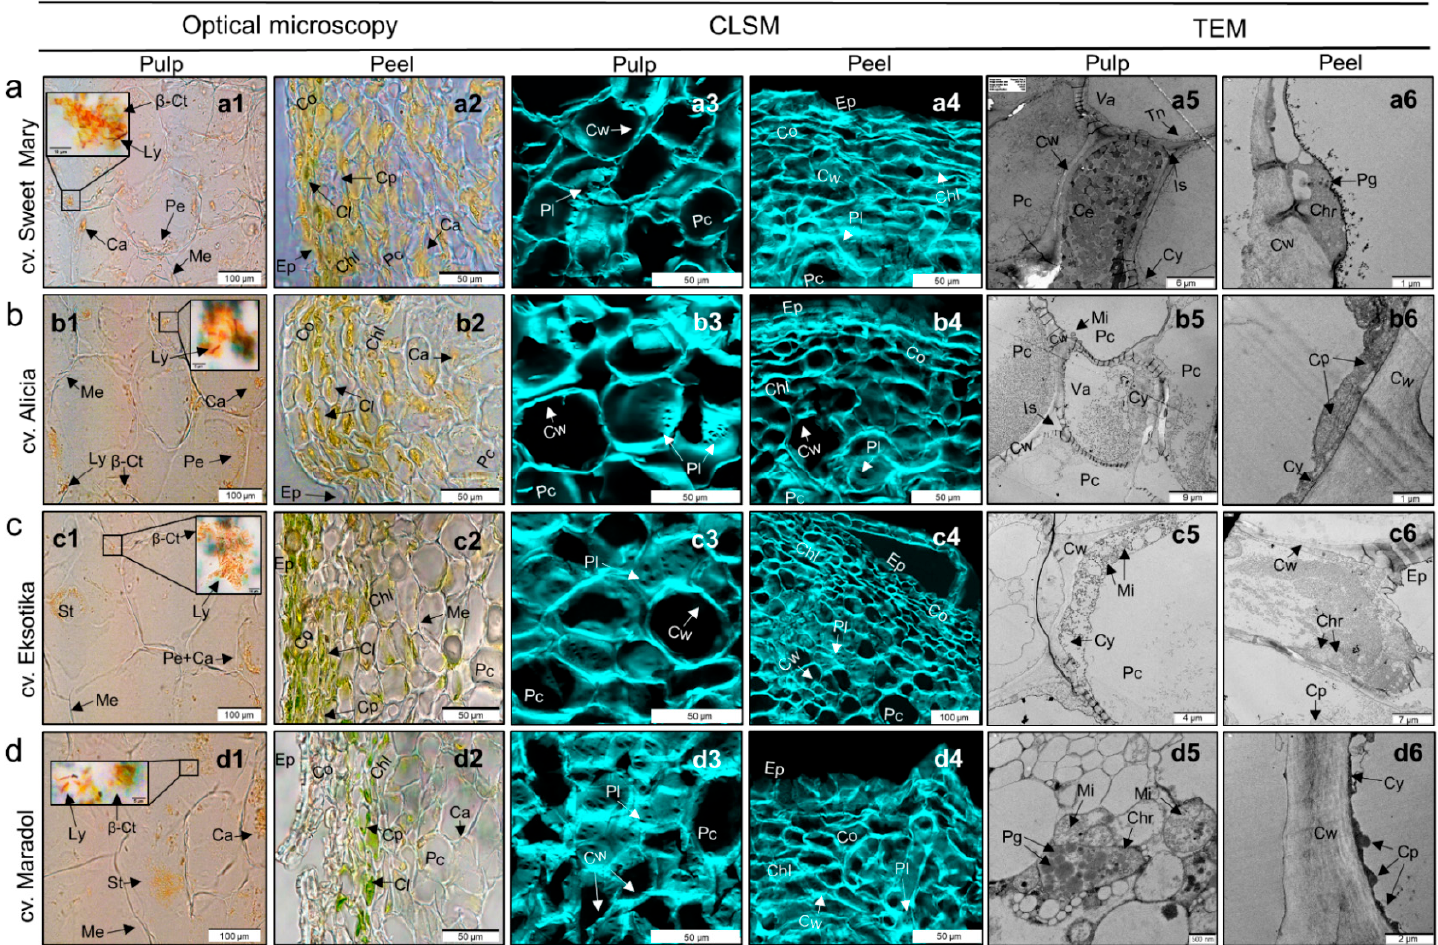
Figure 2. Optical, confocal laser scanning (CLSM), and transmission electron microscopy (TEM) images of ( a ) Sweet Mary, ( b ) Alicia, ( c ) Eksotika, and ( d ) Maradol papaya varieties. β -Ct: β -carotene globular chromoplasts, Ca: carotenoids, Chl: chlorenchyma cell, Chr: chromoplast, Ce: companion cell, Cy: cytoplasm, Cl: chlorophyll, Co: collenchyma cell, Cp: chloroplast, Cw: cell wall, Ep: upper epidermis, Is: intercellular space, Me: membrane, Mi: mitochondria, Ly: lycopene crystalloid formation, Pc: parenchyma cell, Pg: plastoglobuli, Pe: pectin, Pe + Ca: carotenoids surrounded by pectin, Pl: plasmodesma, St: starch granules, Tn: tonoplast, and Va: vacuole.